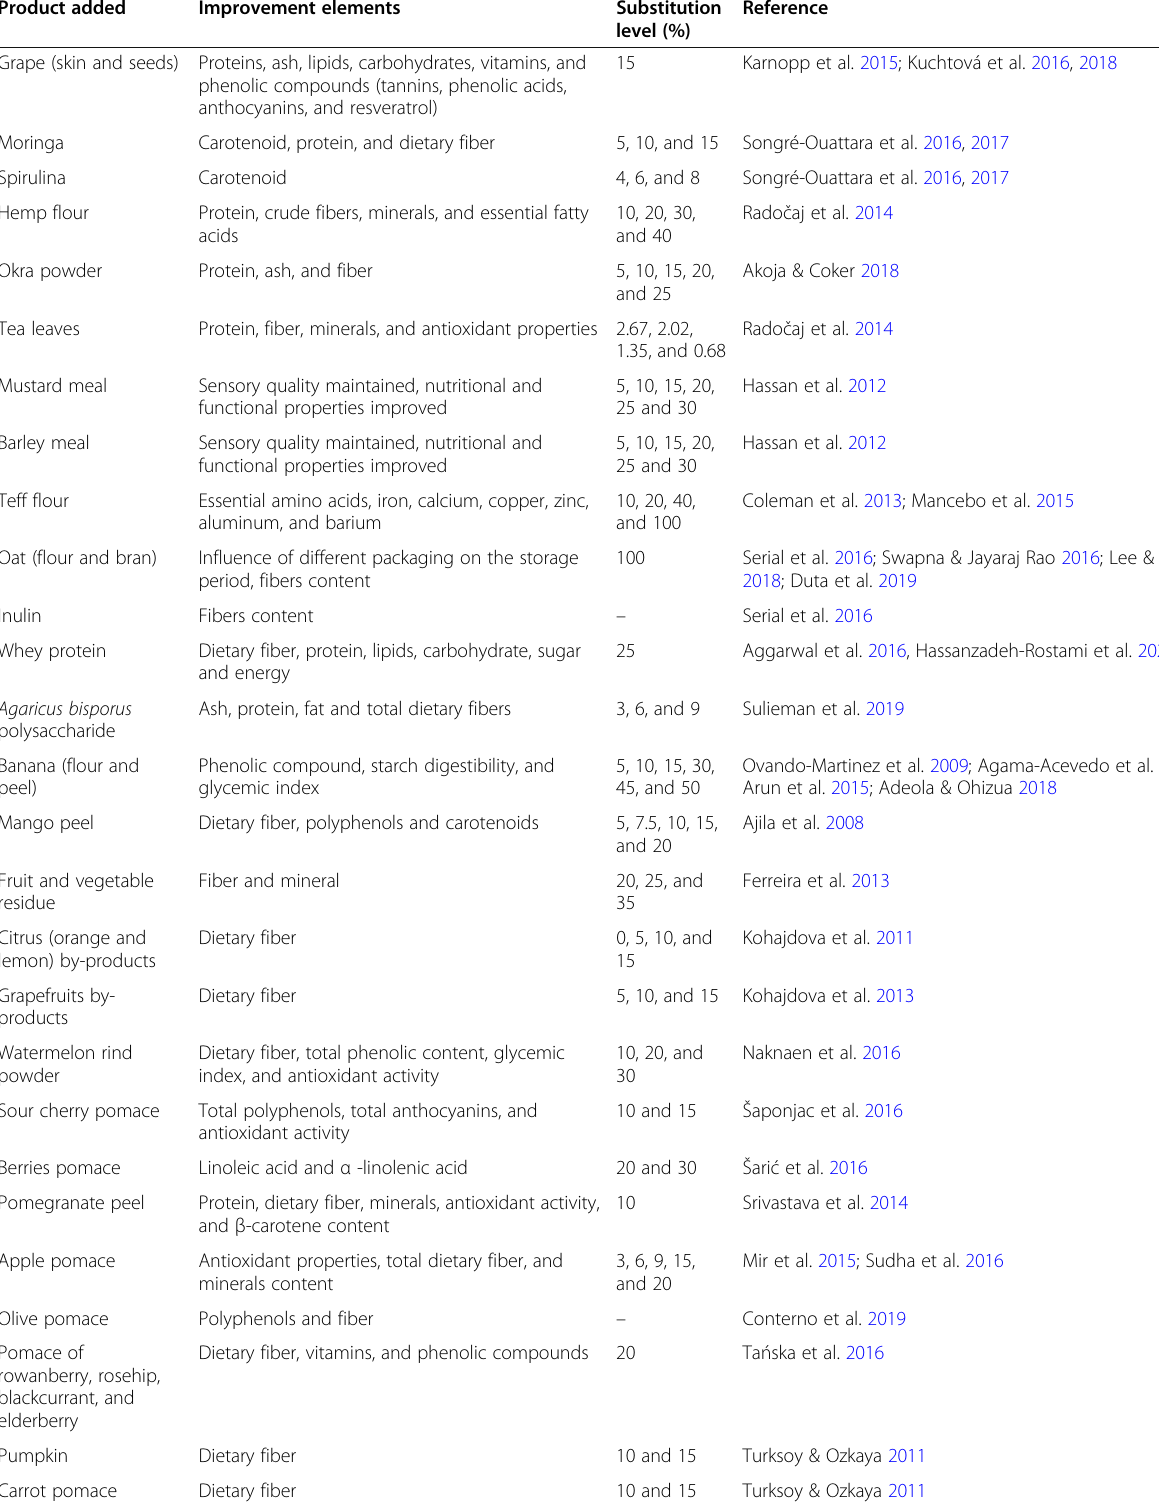
Table 1 Improved materials used to substitute wheat flour in biscuit production